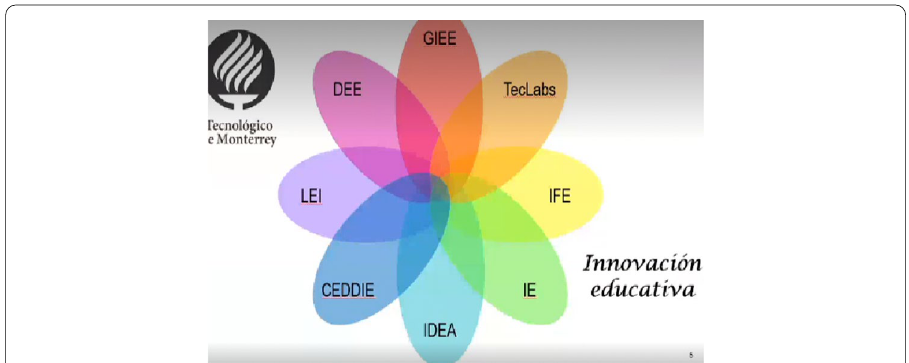
Fig. 11 Initiatives that foster educational innovation at Tecnológico de Monterrey. Source: Valenzuela